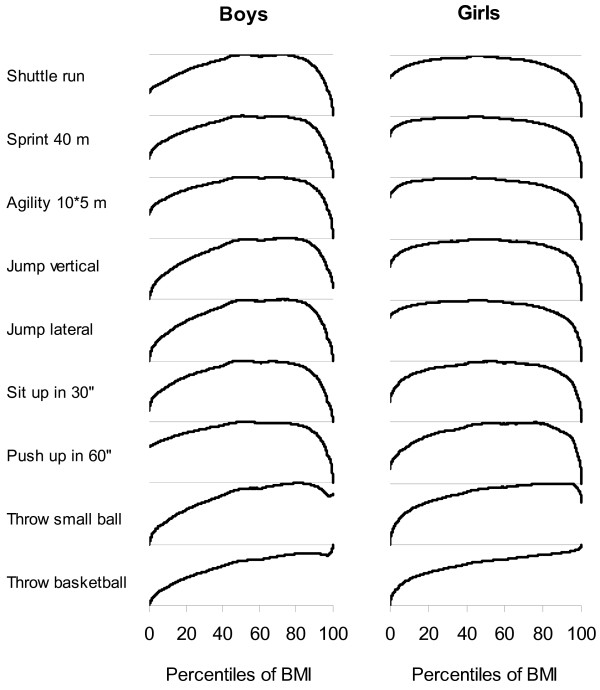
Locally weighted regression between fitness scores and percentiles of body mass index for 9 fitness tests in 2202 boys and 2141 girls aged 12–15 years. Body mass index and fitness scores are standardized for age and fitness scores are calibrated to range from 0 (lowest performance) to 1 (highest performance).